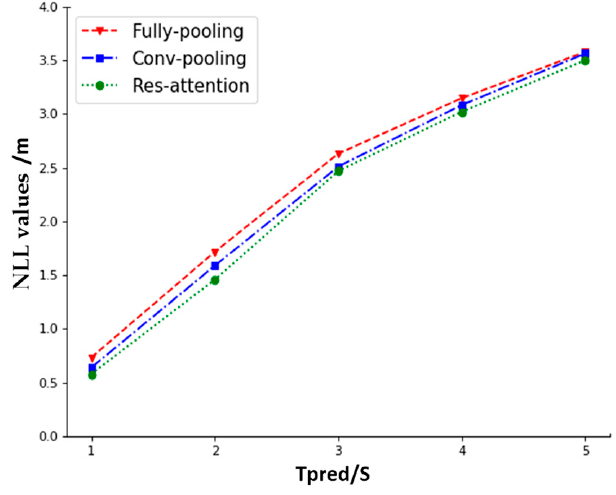
Figure 5. Negative log-likelihood values in the 5 s prediction time domain for each model.